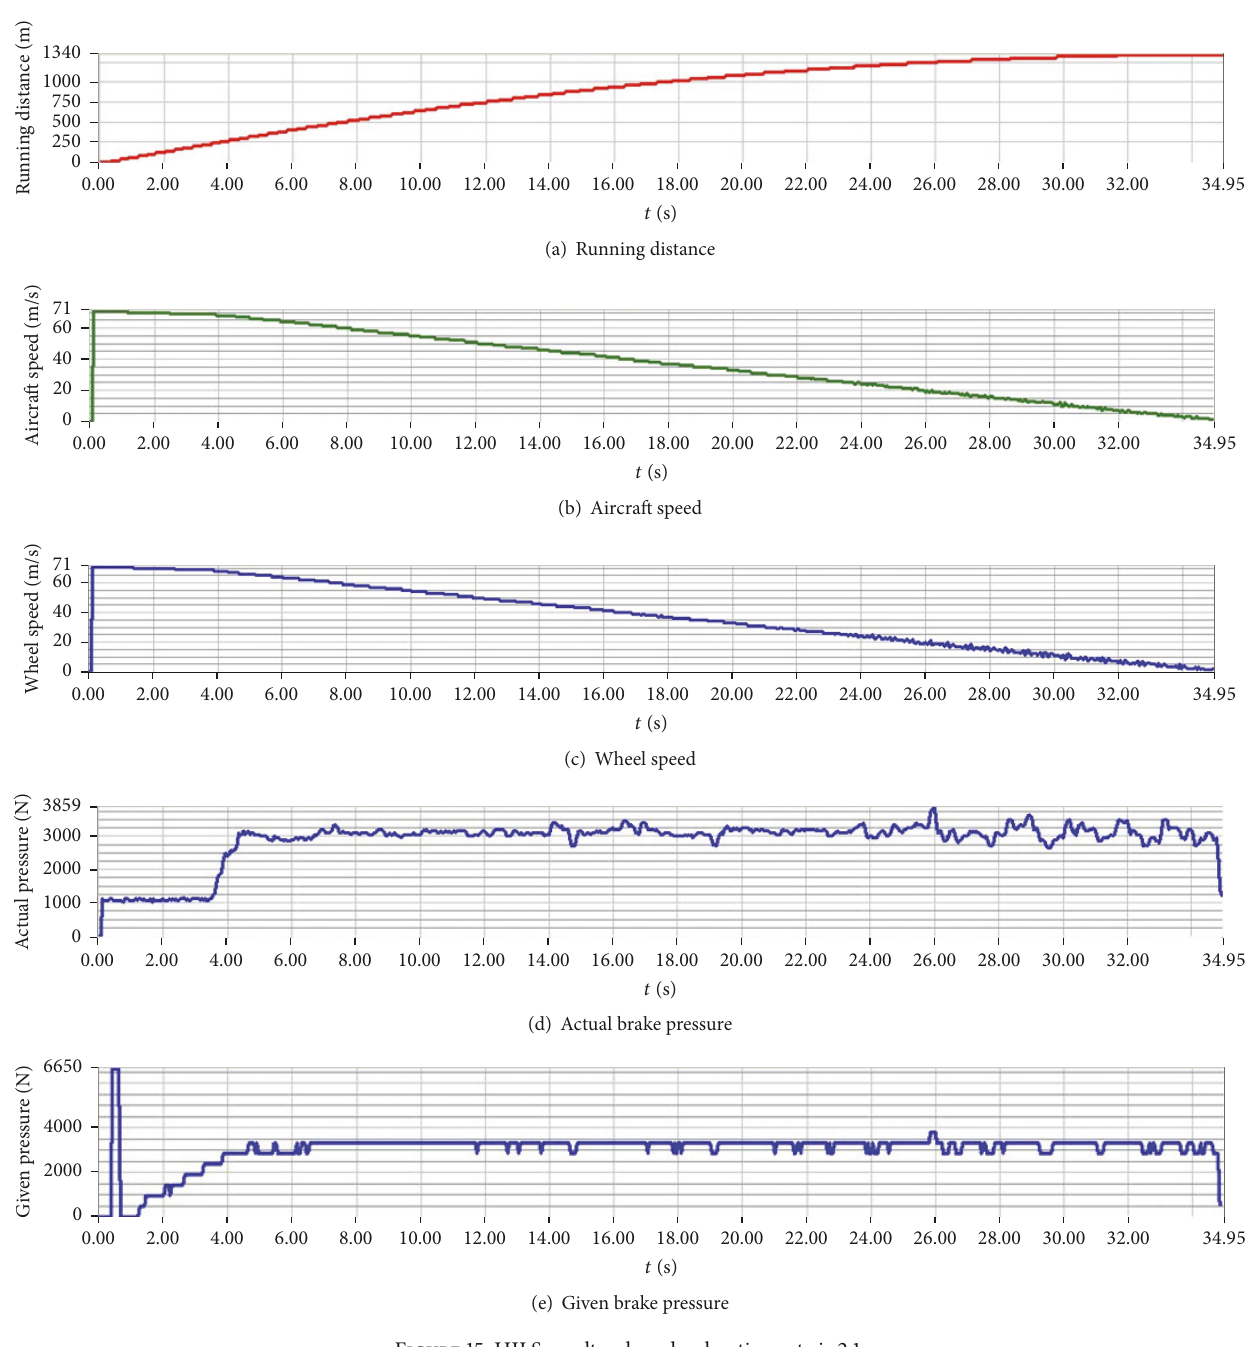
Figure 15: HILS results when deceleration rate is